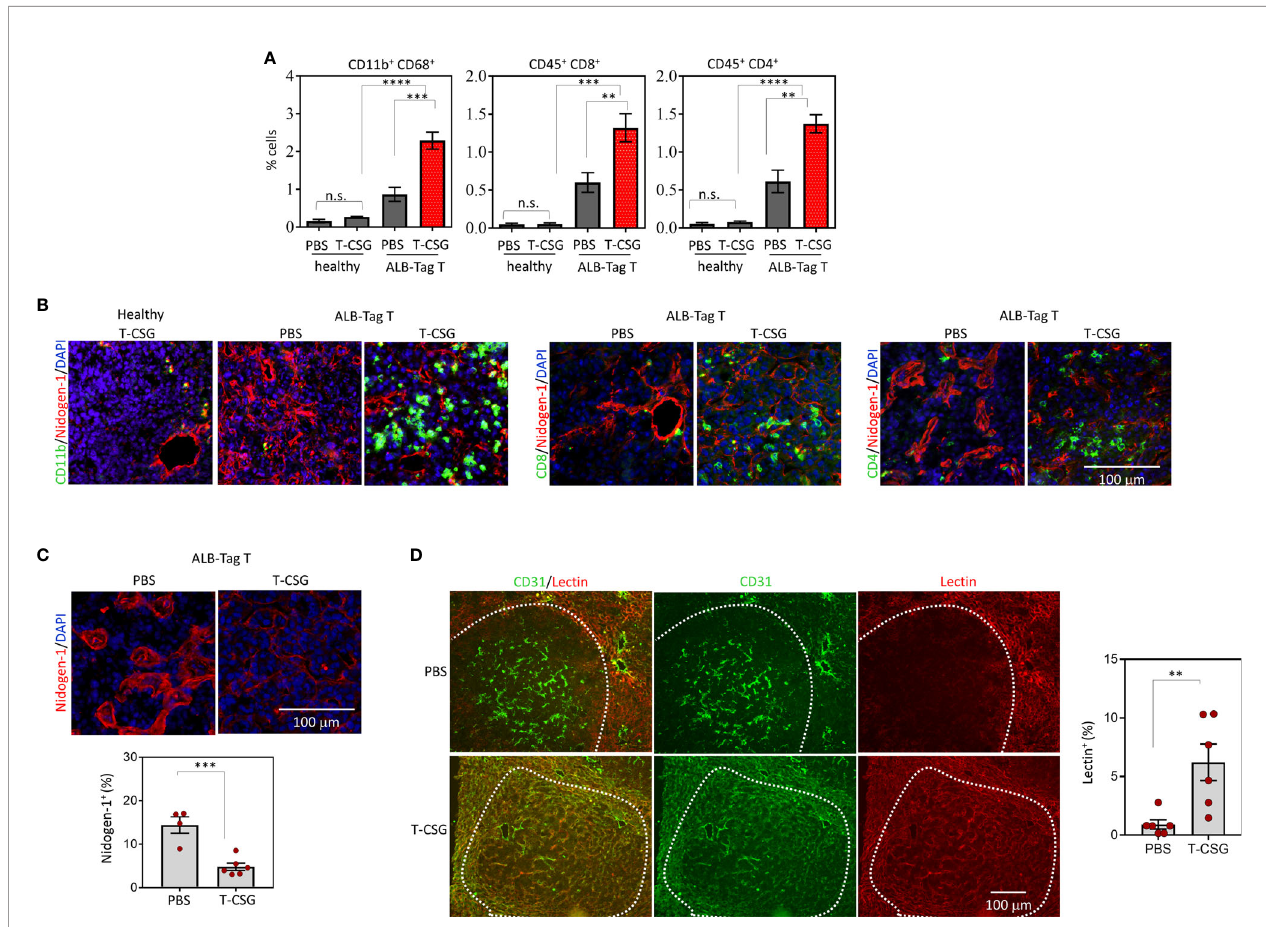
FIGURE 2 | Intratumoral effects of TNF a -CSG on immune cell in fi ltration, ECM content and lectin perfusion. (A) Quanti fi cation of immune cells in HCC and normal liver in ALB-Tag and C3H mice treated with daily i.v. injection of PBS or 5 µg TNF a -CSG for fi ve consecutive days. Bar charts show mean ± SEM of cell counts for macrophages (CD11b + /CD68 + ) and T cells (CD45 + CD8 + or CD45 + CD4 + ) in each treatment group, **P<0.01, ***P < 0.001, ****P< 0.0001 and n.s. (not signi fi cant) when P > 0.05 (by one-way ANOVA test). (B) Co-staining of HCC and normal liver sections treated with fi ve daily doses of indicated compounds, as in panel (A) . Micrographs depict CD11b + cells and CD8 + and CD4 + T-cell (green) in fi ltration particularly around nidogen-1(red)-positive structures. Scale bar: 100 m m. (C) Top: Representative tumors from indicated treatment groups indicating changes to nidogen-1 content (red). Bottom: Quantitative analysis of nidogen-1 staining/ fi eld/tumor in PBS and TNF a -CSG treatment group and mean ± SEM (***P < 0.001 by Student's t -test). (D) Co-staining of lectin-perfused HCC [following treatment as in panel (B, C) ] with CD31 (red, blood vessels). Micrographs show co-localisation (yellow) of lectin and CD31 staining in tumors. Scale bar: 100 m m. Right: Data show the fraction of lectin-positive staining in individual tumors and mean ± SEM (**P < 0.01 by Student ’ s t